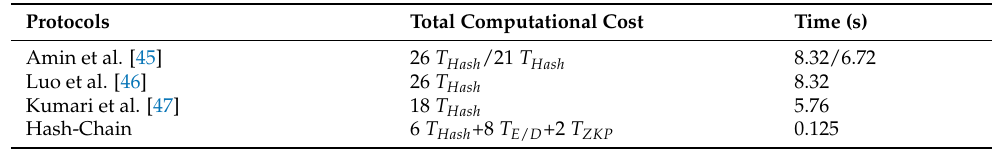
Table 7. Comparison of the computational cost to authenticate 1000